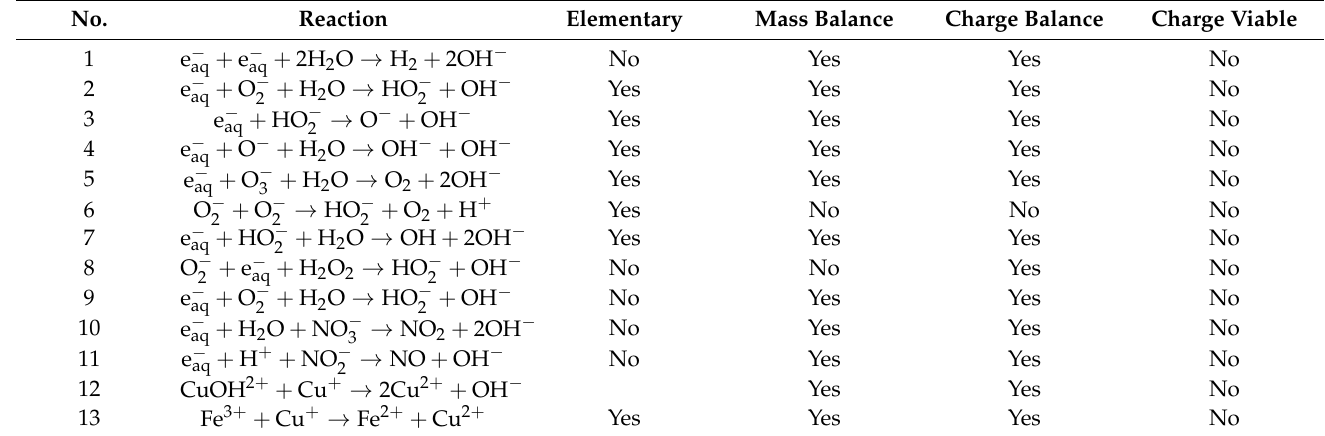
Table 6. Nonviable reactions identified in various radiolysis